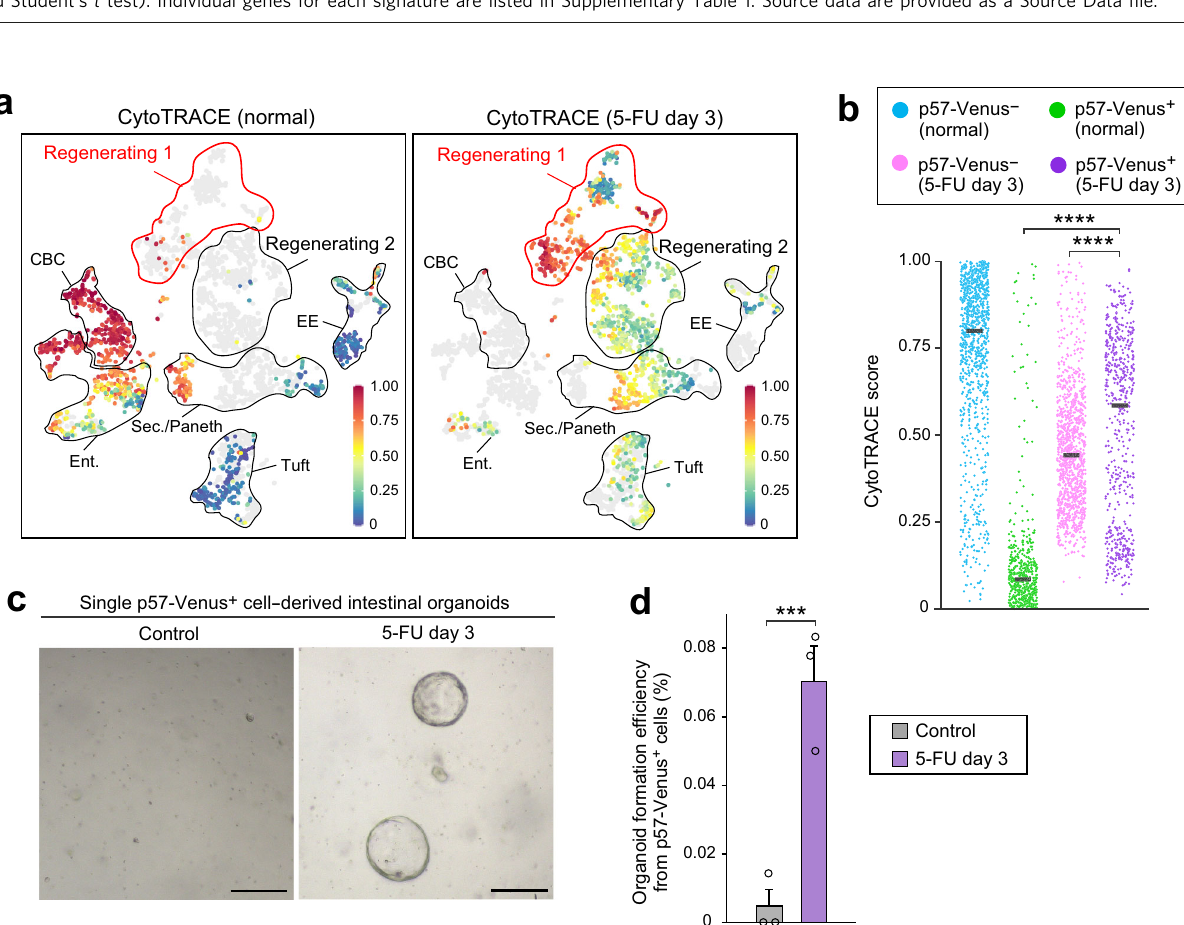
Fig. 5 Single-cell transcriptomics analysis uncovers injury-induced spatiotemporal reprogramming of p57 + cells. a Schematic representation of the experimental procedure for scRNA-seq analysis of normal and regenerating crypt cells from the small intestine of p57-DTR-Venus mice ( n = 2 biological replicates for each condition, with two mice for each replicate). b A t -SNE projection for 567 p57-Venus + (purple) and 1055 p57-Venus ‒ (pink) crypt cells from p57-DTR-Venus mice at 3 days after injection of 5-FU as well as for 472 p57-Venus + (green) and 923 p57-Venus ‒ (cyan) crypt cells from normal p57-DTR-Venus mice is shown in the left panel. Unsupervised clusters are color coded and overlaid on the t -SNE map in the right panel. The indicated cellular identity of each cluster is based on the expression of known cell-type-speci fi c genes (Supplementary Fig. 4d, e). c Heat map for the mean expression level of the indicated Clu + revSC marker genes shown on the t -SNE projection. d Volcano plot showing log 2 (fold change) and – log 10 ( P value) for differentially expressed genes (DEGs) in the Regenerating 1 group (clusters 4, 10, 17, and 18) relative to all other cell clusters. Points colored red indicate the top 100 genes with regard to – log 10 ( P value). Typical revSC- or fetal intestine-speci fi c genes (orange), adult stomach-speci fi c genes (green), and adult intestine-speci fi c genes (blue) are highlighted. e , f Heat maps for the mean expression level of fetal intestine signature genes ( e ) or of adult stomach signature genes ( f ) shown on the t -SNE projection. g , h Heat maps for the abundance of Nkx6-3 ( g ) and Ascl2 ( h ) mRNAs shown on the t -SNE projection. FC, fold change. i RT-qPCR analysis of relative mRNA abundance for representative marker genes of revSCs or fetal intestine, or for those of adult stomach, in sorted normal and postinjury p57-Venus + cells. Data are means + SEM ( n = 3 mice). NS (not signi fi cant), * P < 0.05, ** P < 0.01, **** P < 0.001 (two-